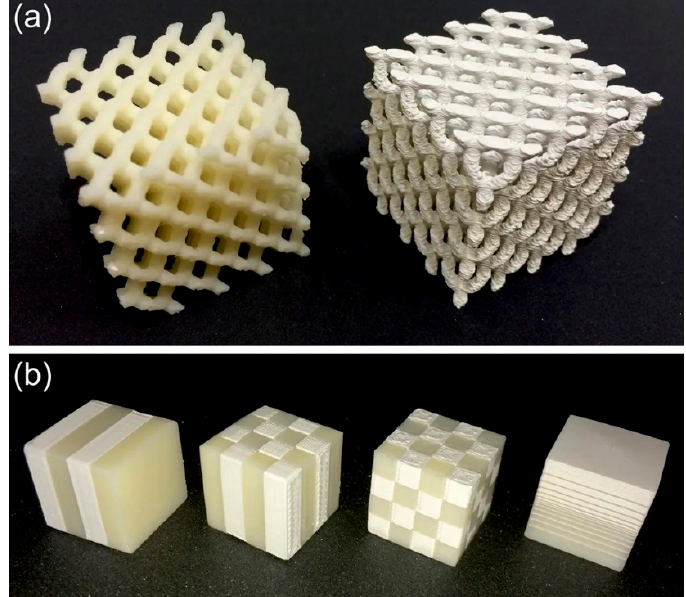
Figure 16. Three-dimensional-printed polymer composite parts. ( a ) Example rod-connected diamond photonic crystal structures printed in ABS polymer (left, ε ′ = 2.57) and 50 wt% BaTiO 3 /ABS polymer composite (right, ε ′ = 4.95). Scale: each cubic structure has overall side length of 32 mm (8 mm unit cell). ( b ) Example 1D, 2D, and 3D periodic structures and a 1D graded structure printed using a combination of ABS polymer and 50 wt% BaTiO 3 in ABS polymer composite. Scale: each cubic structure has side length of 16 mm. Reprinted from [51], © 2016, with permission from Springer Nature.